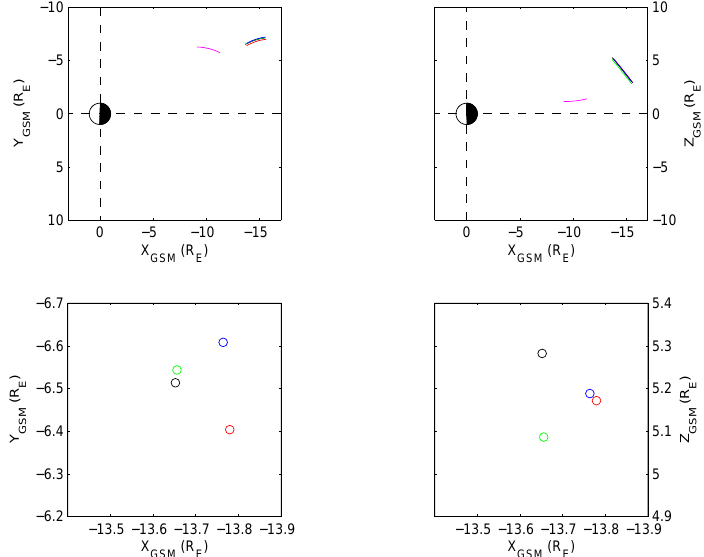
Fig. 1. Top panels: The location of Cluster (black, red, green and blue) and TC-1 (magenta) in GSM coordinates in the xy - plane (left) and the xz -plane (right). Bottom panels: The relative locations of the 4 Cluster spacecraft in GSM coordinates with the usual colours in the xy - plane (left) and the xz -plane